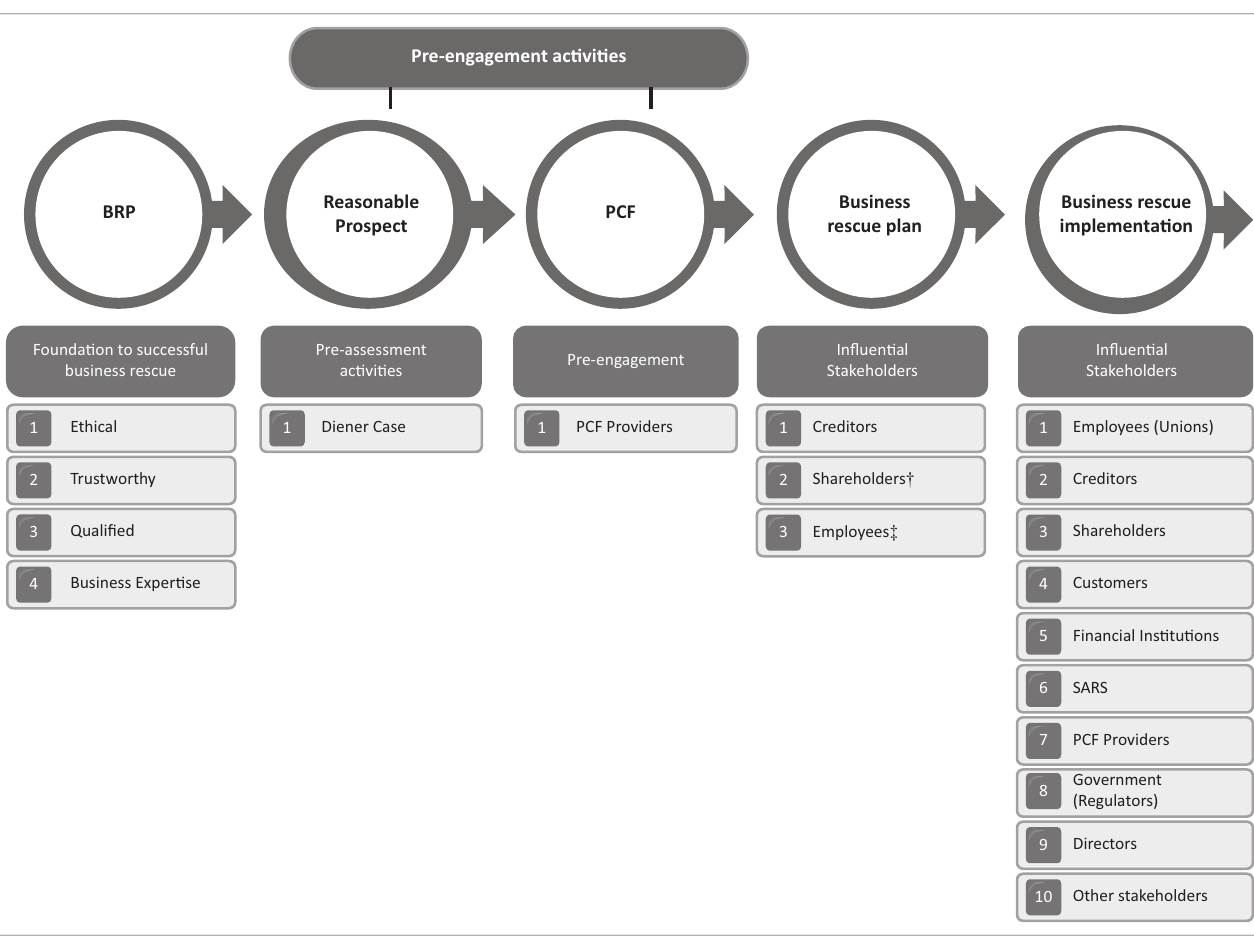
FIGURE 3: Business rescue stakeholder analysis